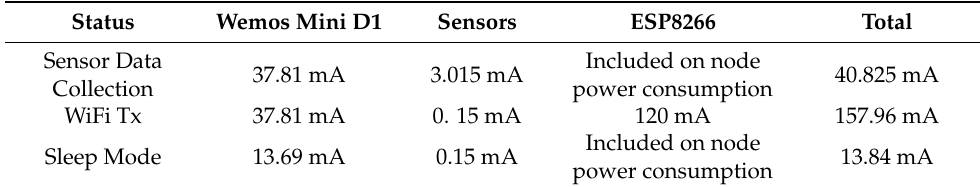
Table 4. Power consumption for each